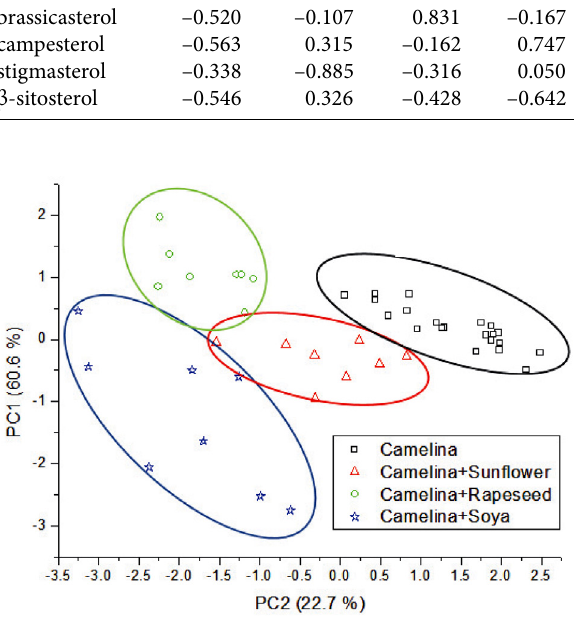
Figure 3. Projection of 21 objects of camelina oil and 4 for mixtures of camelina with sunflower oil, 4 for mixtures of camelina with rapeseed oil and 4 for mixtures of camelina with soya oil, onto the plot defined by the first and second principal components. The PCA model was calculated based on sterol composition.